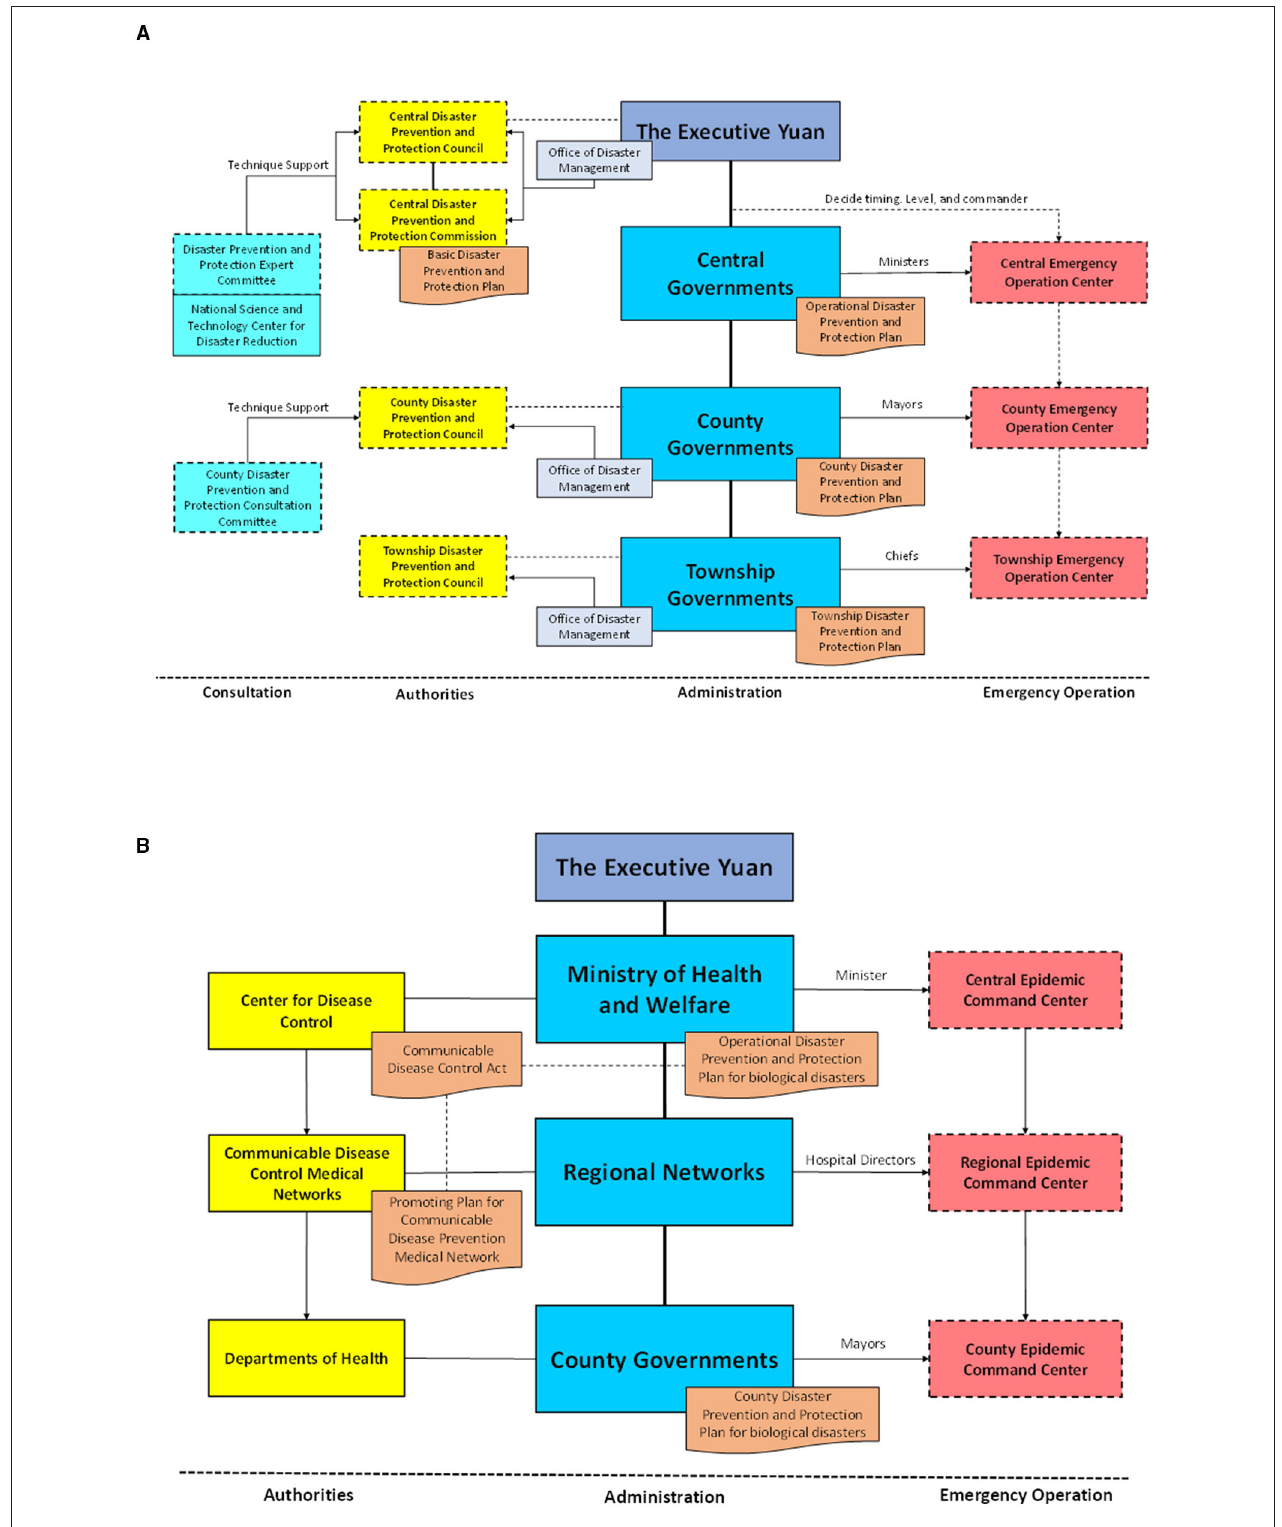
FIGURE 5 | Disaster management frameworks in Taiwan for (A) natural disasters and (B) communicable diseases.